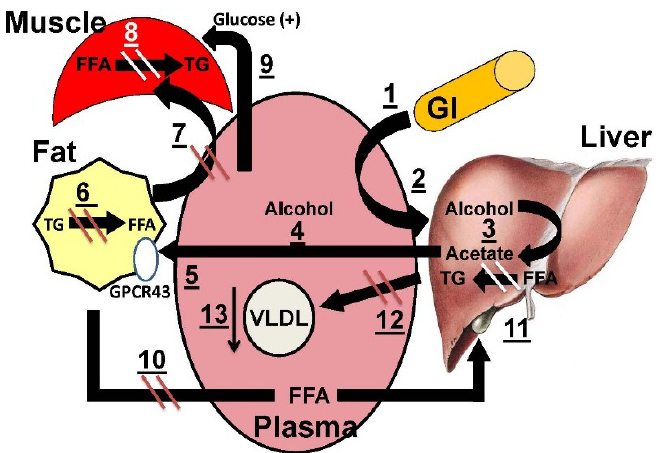
Figure 1. Hypothetical model for the effects of alcohol ingestion on plasma lipids and lipoproteins. See text for